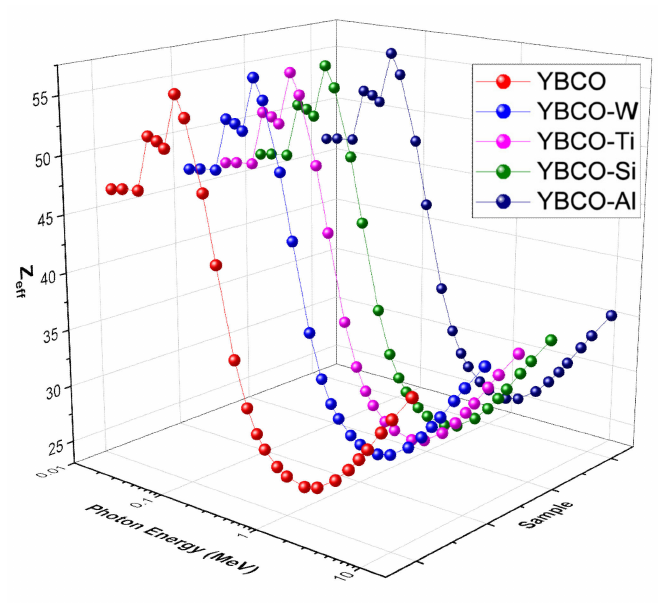
Figure 9. Z eff values for the prepared